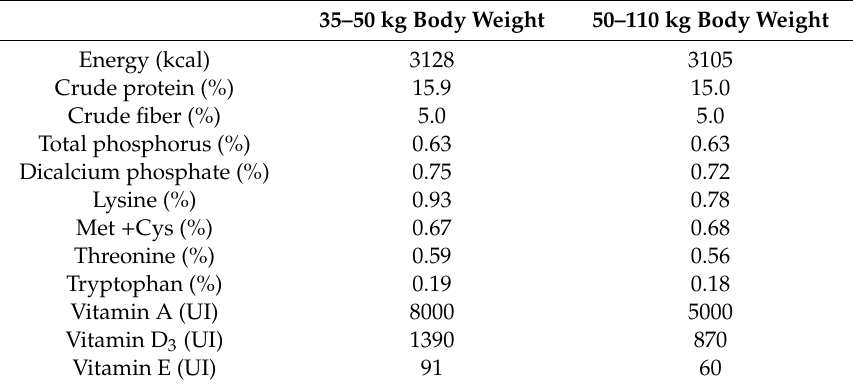
Table 1. Chemical composition of one kilogram basal diet.